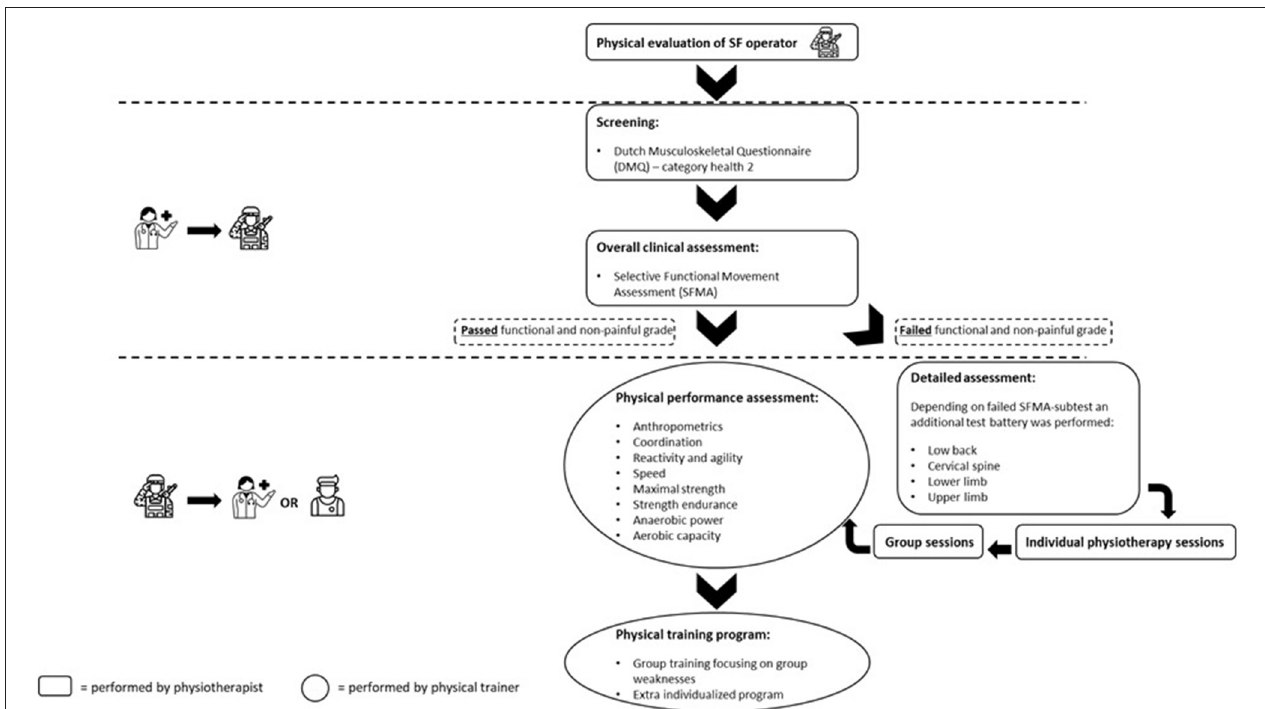
FIGURE 2 | Flow chart of the physiotherapy assessment and transition to the physical training instructor evaluations. “Screening” and “Overall clinical assessment” are performed by the physiotherapist in the unit, “Detailed assessment” in the Center for Physical Medicine and Rehabilitation of the Military Hospital Queen Astrid and the “Physical performance assessment” is done by the unit physical training